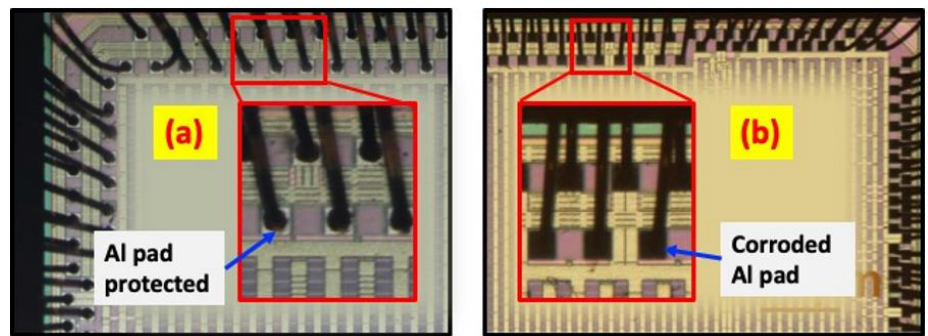
Figure 13. Copper-specific inhibitor coated to WBD immersed in ( a ) 5 ppm Cl − , pH 5 solution for more than 24 h showing Al pad protection and no Cu wire lift-off (inset: zoomed-in image of Al bond pad region remaining protected) and ( b ) 5 ppm F − , pH 5 solution for more than 24 h showing complete corrosion of Al bond pad (inset: zoomed-in image of Al bond pad region corroded).